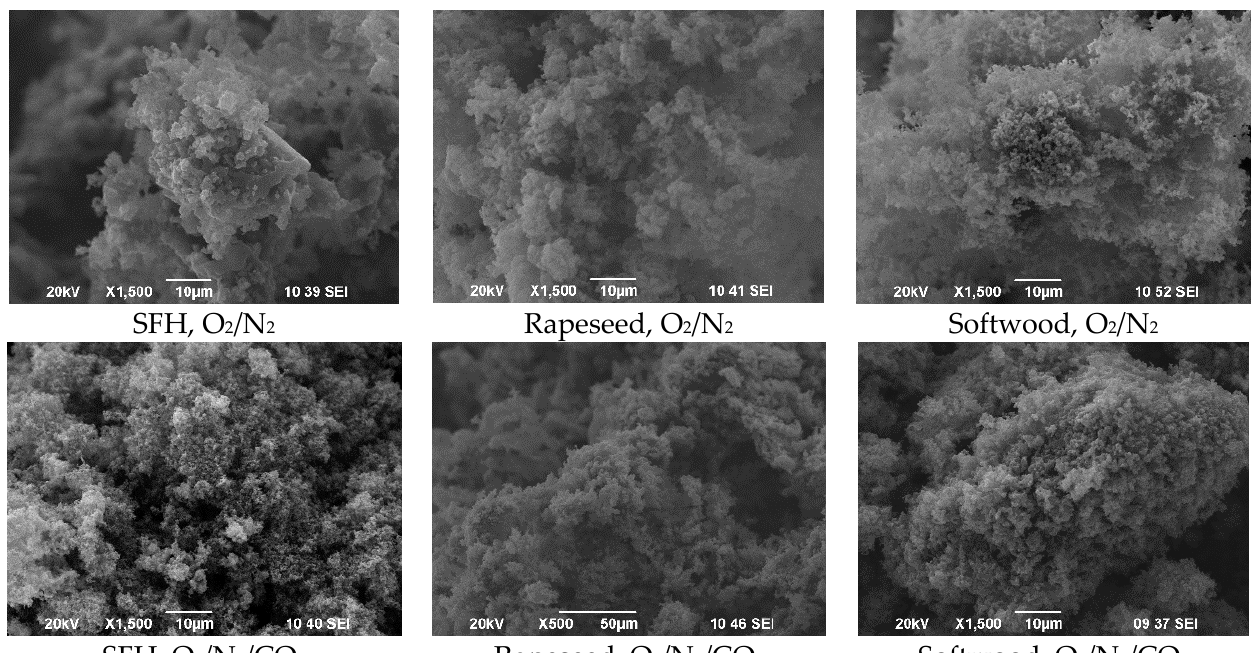
Figure 6. SEM images of PM from filter 8 (PM 1 ).